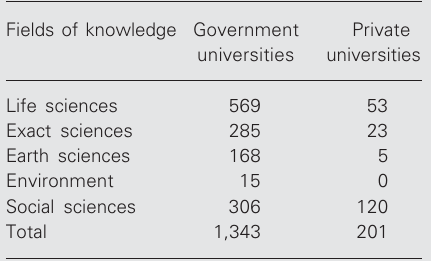
Table 2. Graduate courses.